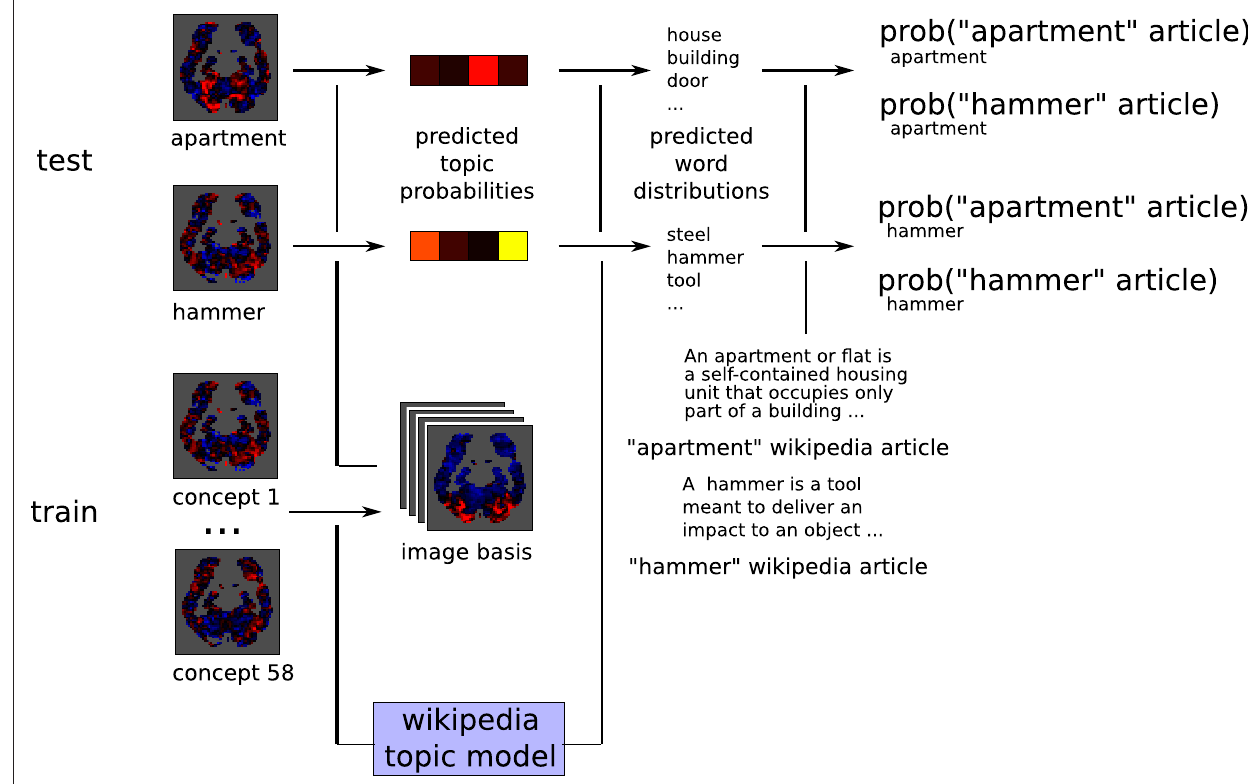
FIguRe 4 | Classification procedure for the “apartment” and “hammer” example